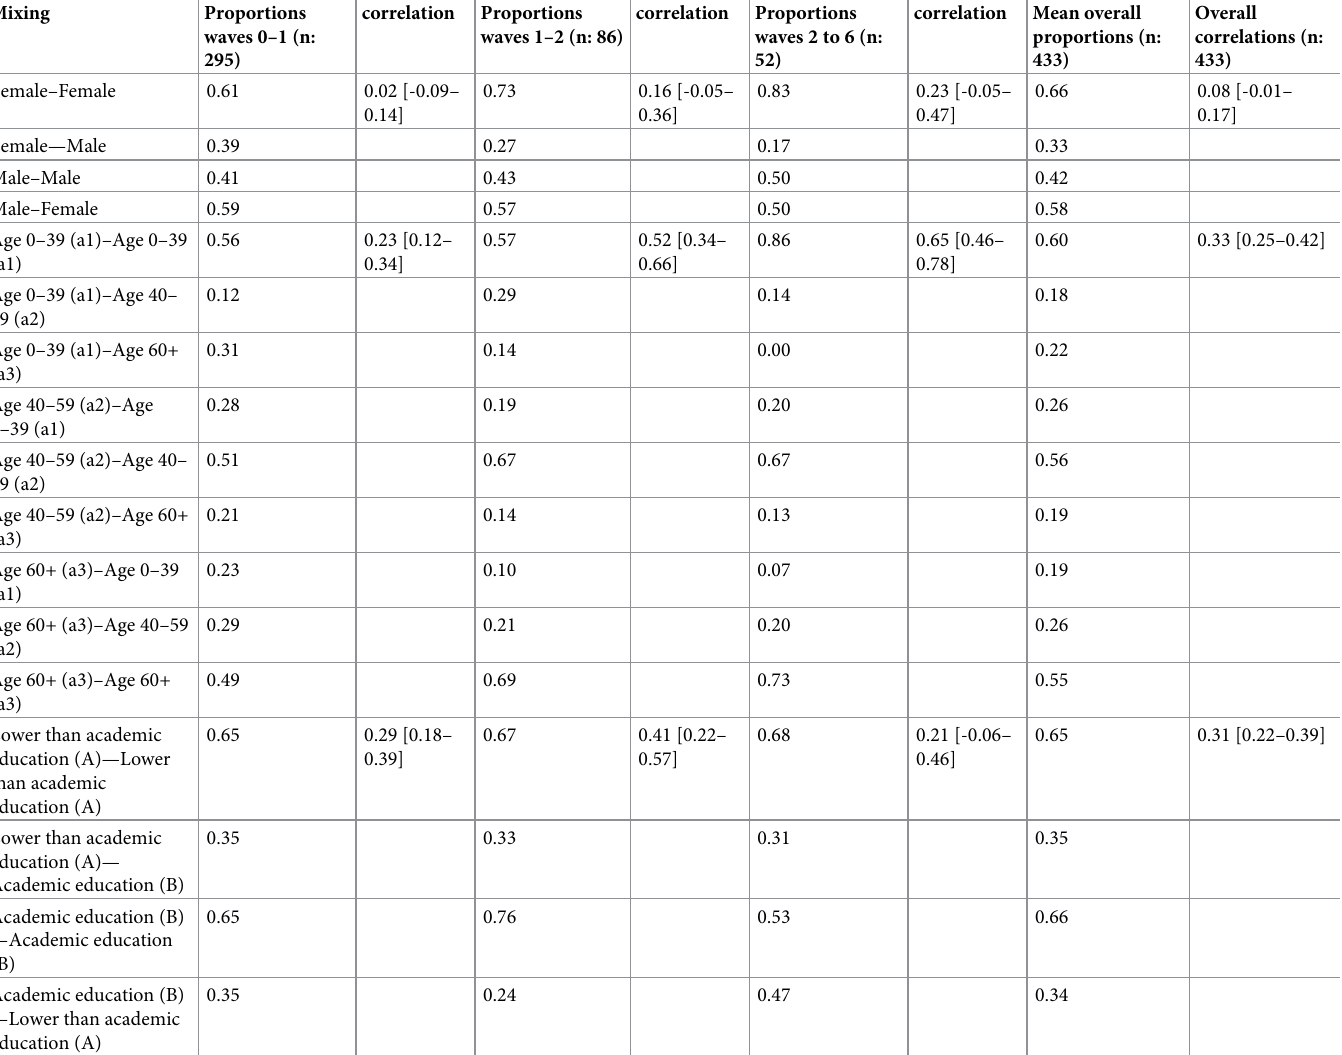
Table 2. Heterogeneity in recruitment mixing behaviour over waves as observed during RDD survey in the Netherlands.